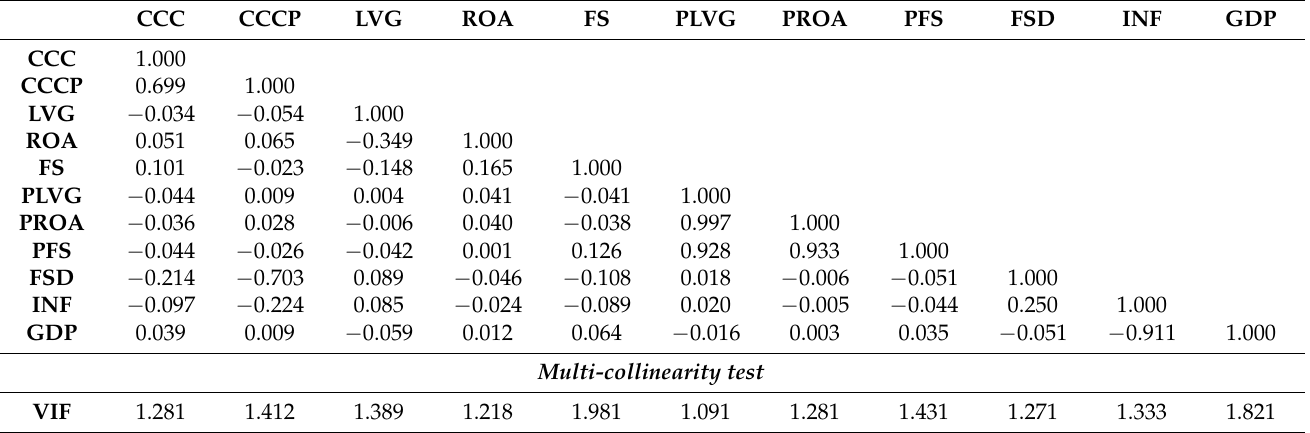
Table 4. Correlation